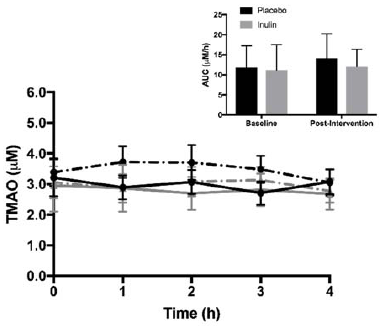
Figure 1. Fasting and postprandial trimethylamine N ‐ oxide (TMAO) concentrations. Inset: Area under the curve (AUC) between placebo and inulin groups. Values are expressed as mean ± standard error of the mean. placebo at baseline, inulin at baseline, placebo post ‐ intervention, inulin post ‐ intervention.